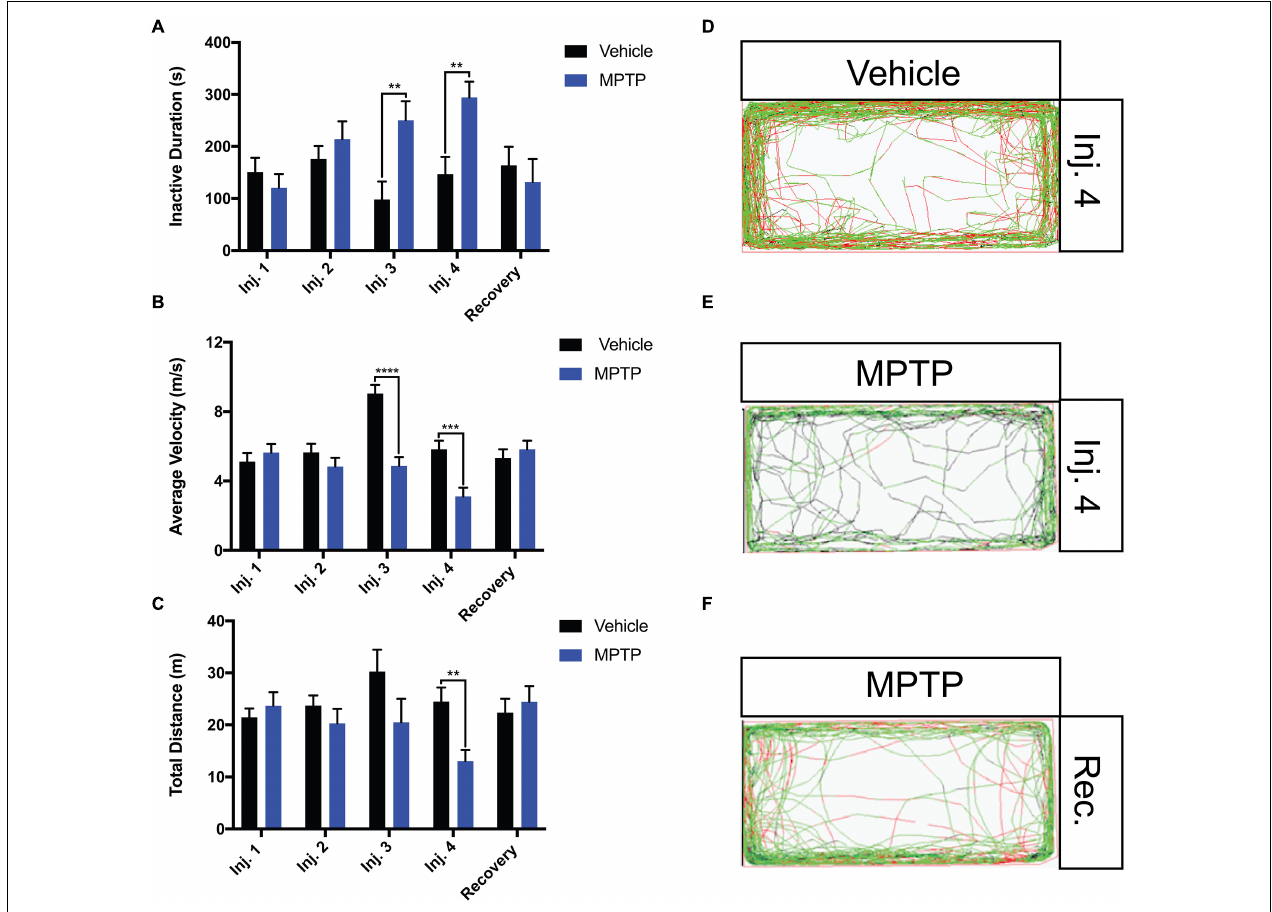
FIGURE 3 | Impact of MPTP on adult zebrafish swimming behavior. Fish were acclimated to the apparatus for 15 min prior to behavioral analyses. Seven-minutes trials were performed. (A–C) Analysis of inactive durations (proxy for freezing bouts), average velocity and total distance for MPTP injected zebrafish and vehicle controls. Respective path images are as follows; injection 4 vehicle control (D) , injection 4 MPTP (E), and 2-week recovered MPTP treated zebrafish (F) . Red lines represent fast movement, green lines represent slow movement and black lines represent inactive movement below the slow threshold ( n = 10 for all groups). Bars represent the mean ± the SEM. ** p < 0.01, *** p < 0.001, and **** p < 0.0001.